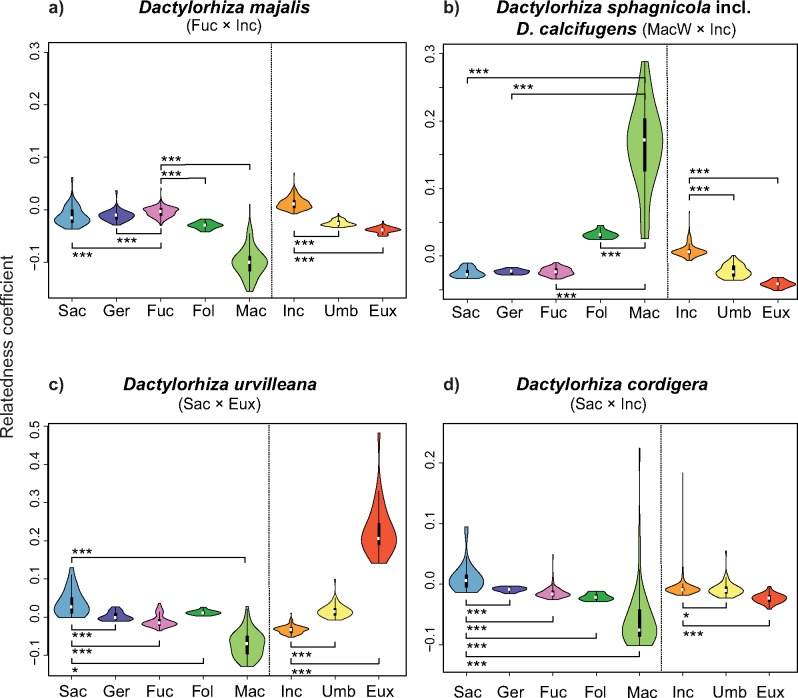
Examples of violin plots of relatedness of Dactylorhiza allotetraploids to potential ancestral genomes (diploid or autotetraploid): a) D. majalis; b) D. sphagnicola (including D. calcifugens); c) D. urvilleana; and d) D. cordigera. Within each panel, plots of relatedness of the allotetraploids to members of the D. fuchsii-maculata clade are shown to the left of a dashed vertical bar and members of the D. incarnata-euxina clade to the right. Stars indicate significantly different distributions (*\documentclass[12pt]{minimal}
\usepackage{amsmath}
\usepackage{wasysym}
\usepackage{amsfonts}
\usepackage{amssymb}
\usepackage{amsbsy}
\usepackage{upgreek}
\usepackage{mathrsfs}
\setlength{\oddsidemargin}{-69pt}
\begin{document}
}{}$P \quad <$\end{document} 0.05; *** \documentclass[12pt]{minimal}
\usepackage{amsmath}
\usepackage{wasysym}
\usepackage{amsfonts}
\usepackage{amssymb}
\usepackage{amsbsy}
\usepackage{upgreek}
\usepackage{mathrsfs}
\setlength{\oddsidemargin}{-69pt}
\begin{document}
}{}$P \quad <$\end{document} 0.001). Eux = D. euxina, Fol = D. foliosa, Fuc = D. fuchsii, Ger = D. gervasiana, Inc = D. incarnata, Mac = D. maculata, Sac = D. saccifera, Umb = D. umbrosa. Plots for the rest of the allotetraploids are given as Supplementary Fig. S4 available on Dryad.